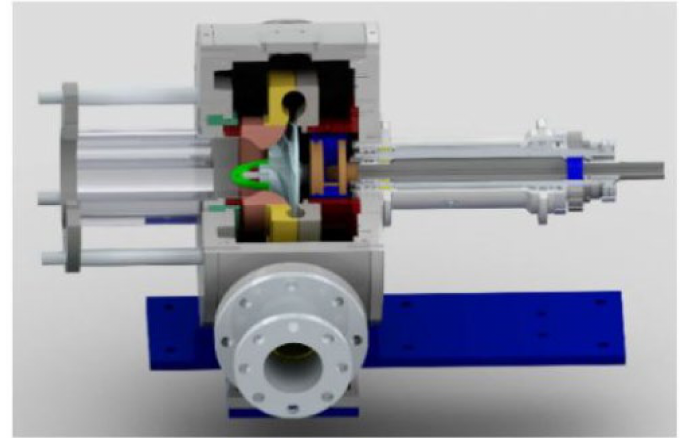
Figure 14. Cut-section for the rotor dynamic test facility [55].